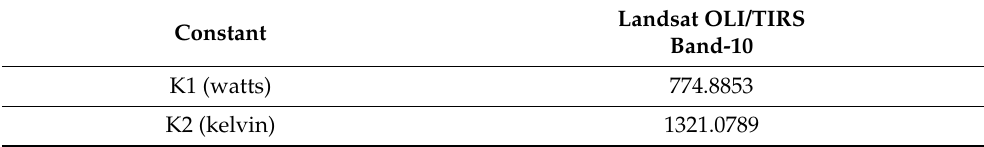
Table 2. Constant K1 and K2 for Landsat